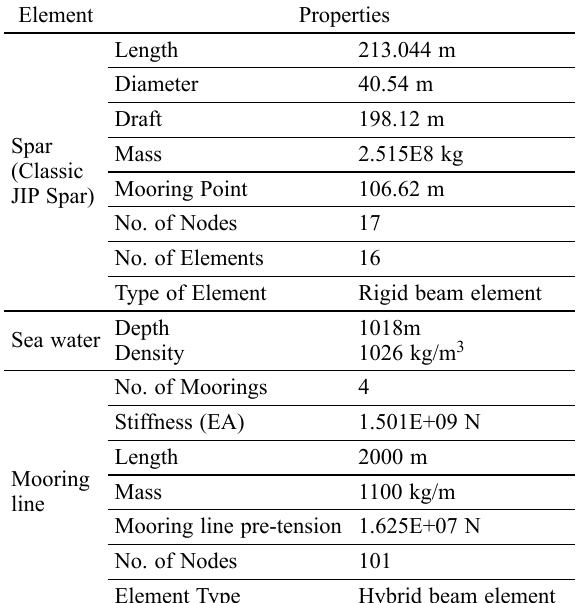
Table 2. Hydrodynamic properties